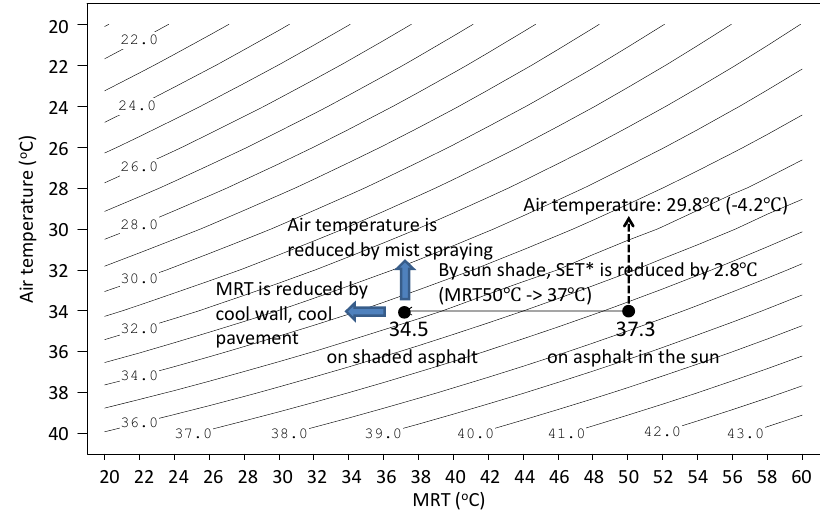
Figure 5. Relationships between air temperature, MRT, and SET*. SET* is indicated by a contour line. The relative humidity is 50%, wind speed is 1 m/s, clothing insulation is 0.6 clo, and metabolic rate is 2 Met.